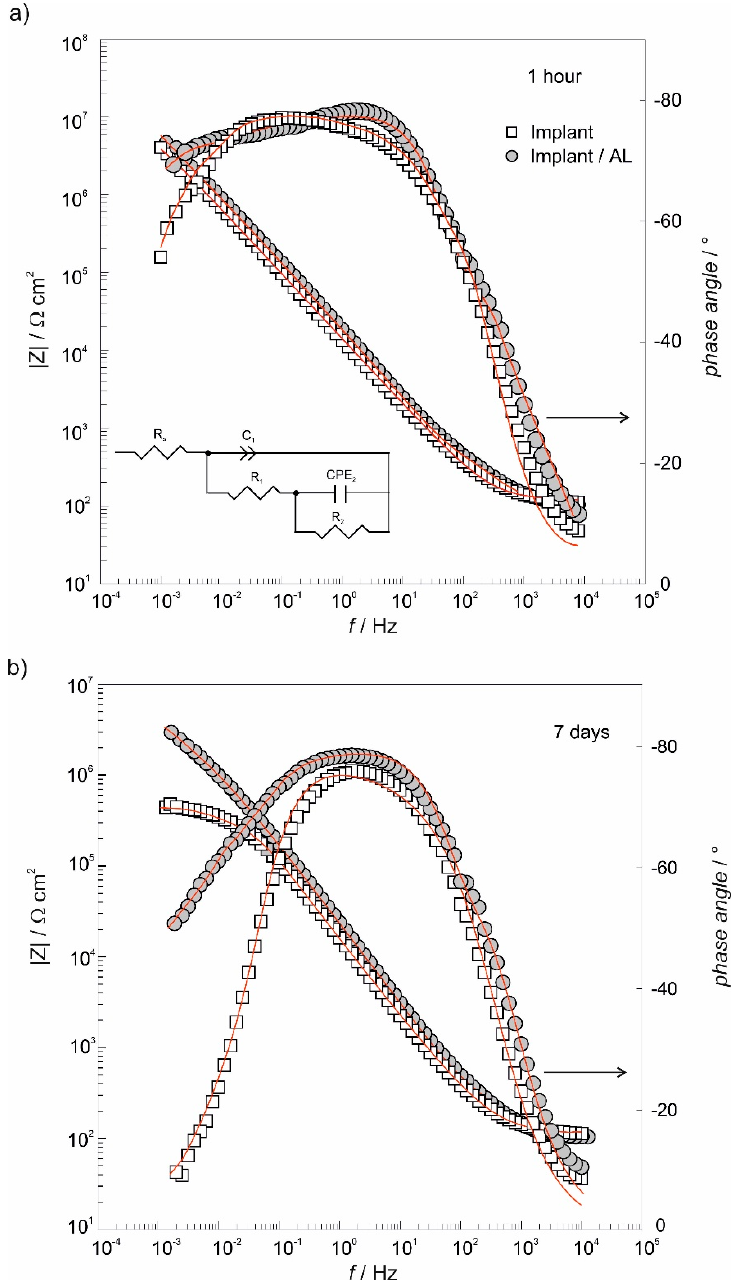
Figure 5. Electrochemical impedance spectroscopy (EIS) responses of as-received implant (Implant) and alendronate-coated implant (Implant/AL) samples recorded after ( a ) 1 h- and ( b ) 7 days-stabilization period at the open circuit potential in the artificial saliva, pH = 6.8. Symbols: the experimental data; solid lines: the modeled data.